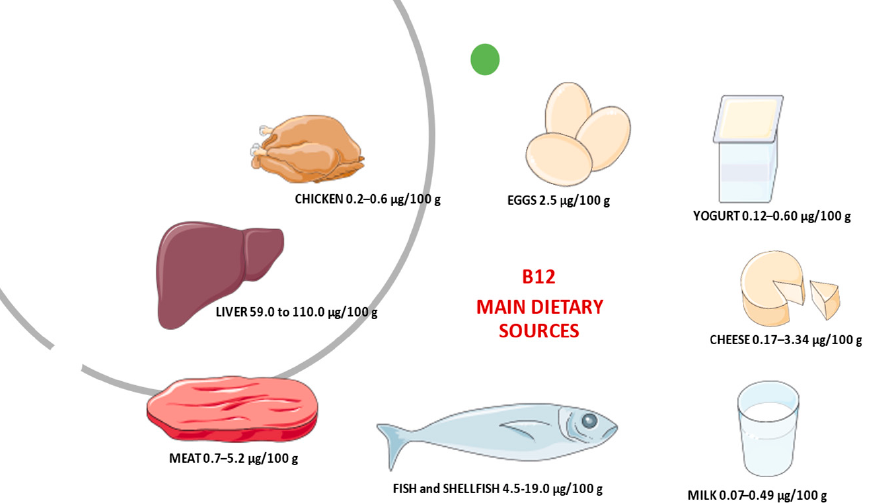
Figure 1. The average content of B 12 in animal dietary